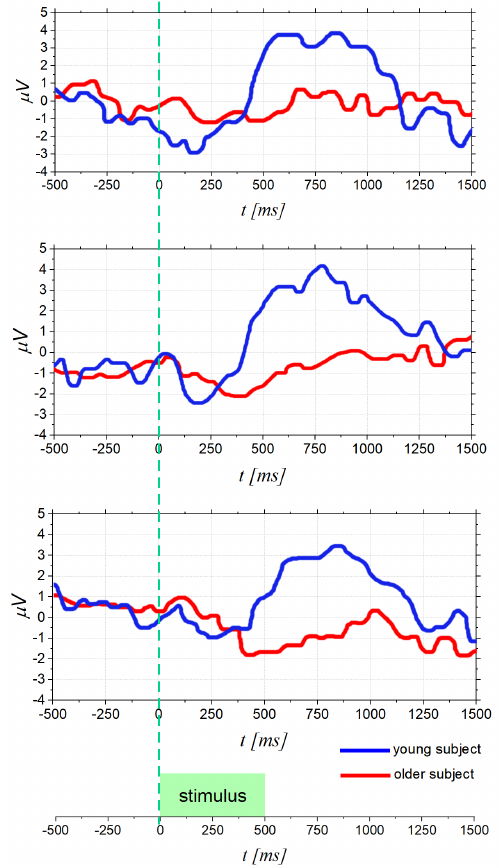
Figure 5. OERPsfor different examples of young and older subjects. OERP amplitude of an older participant is smaller and the peak latency is longer than that of a young participant